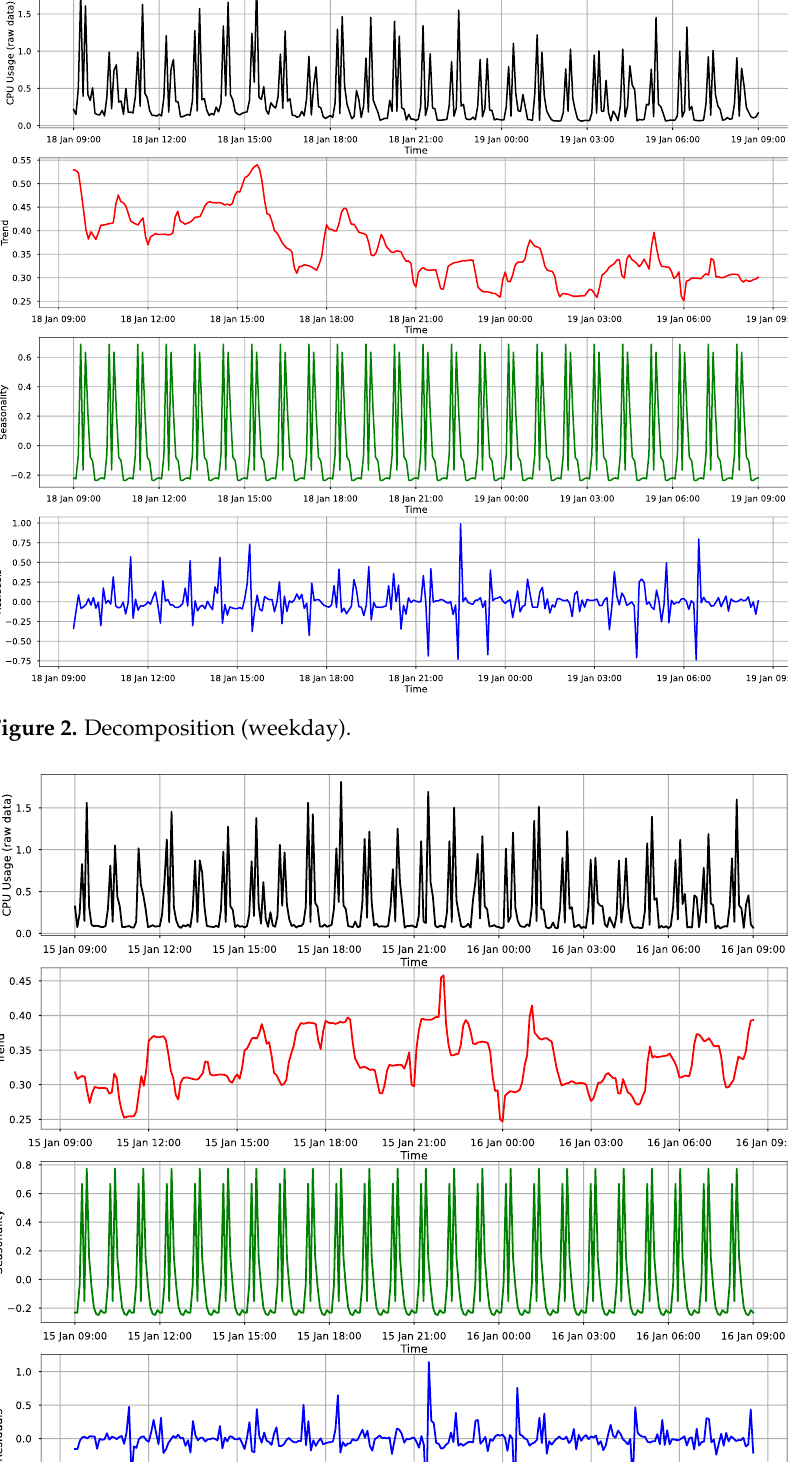
Figure 3. Decomposition (weekend). Figure 4 shows all the monitored components in the